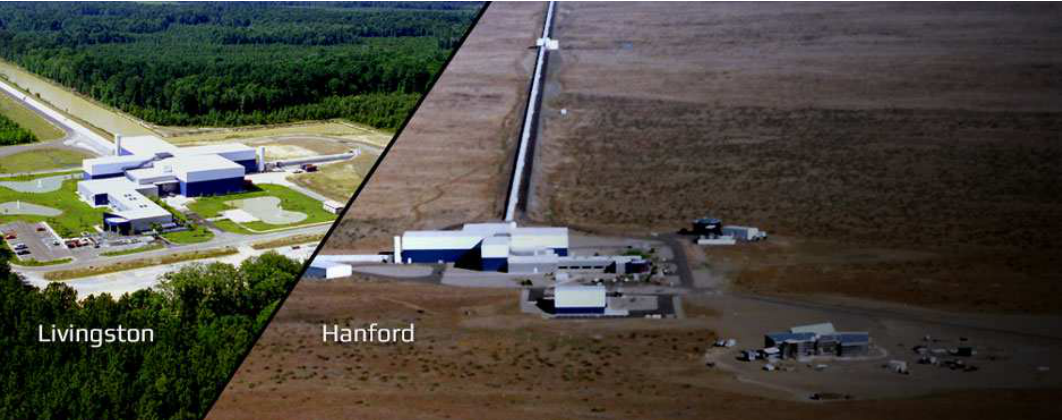
Figure 3. This is the picture of the Laser Interferometer Gravitational Wave Observatory, abbreviated as LIGO. There are two twin detectors in Livingston, Lousiana and Hanford, Washington separated by 3000 km. The arm length is 4 km. (Image credit: